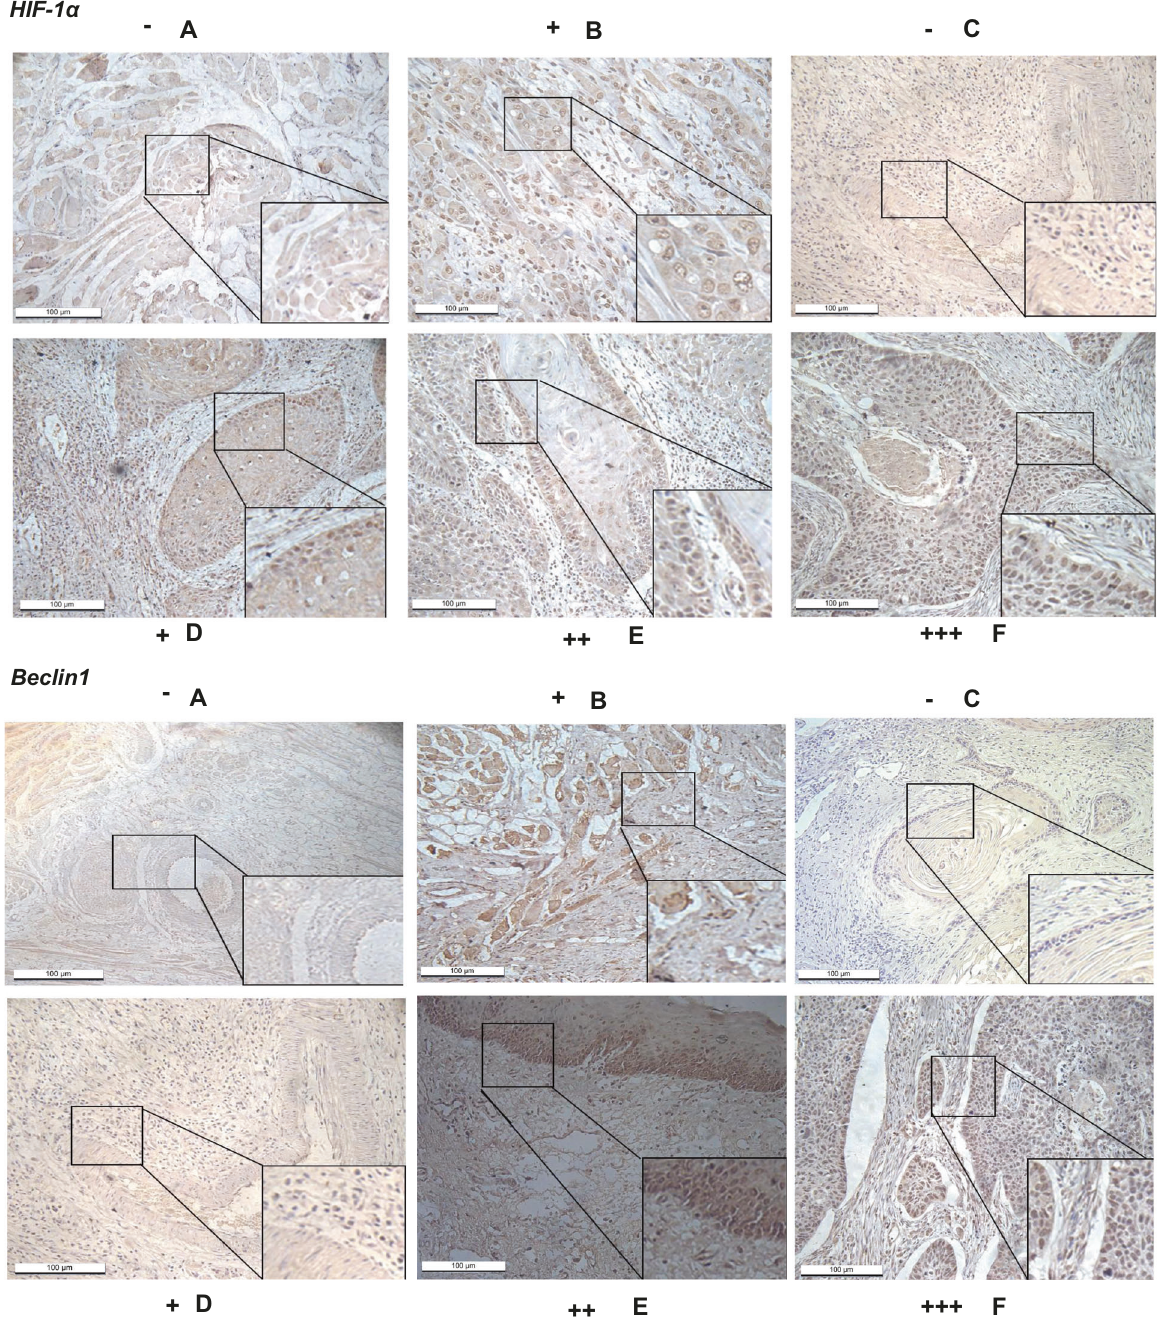
Fig. 1 The expression level of HIF-1 α and Beclin1 in OSCC tissues and para cancer tissues (×200) HIF-1 α was mainly expressed in the cell nucleus while Beclin1 was mainly located in the cell membrane and cytoplasm with a small amount in the cell nucleus. The positive staining of HIF-1 α and Beclin1 showed uniform light yellow, brownish-yellow, or tan granules. A , B Normal tissue. C – F OSCC tissues. HIF-1 α hypoxia-inducible factor-1 α , Beclin1, a coiled-coil Bcl-2-interacting protein homologous, OSCC oral squamous cell